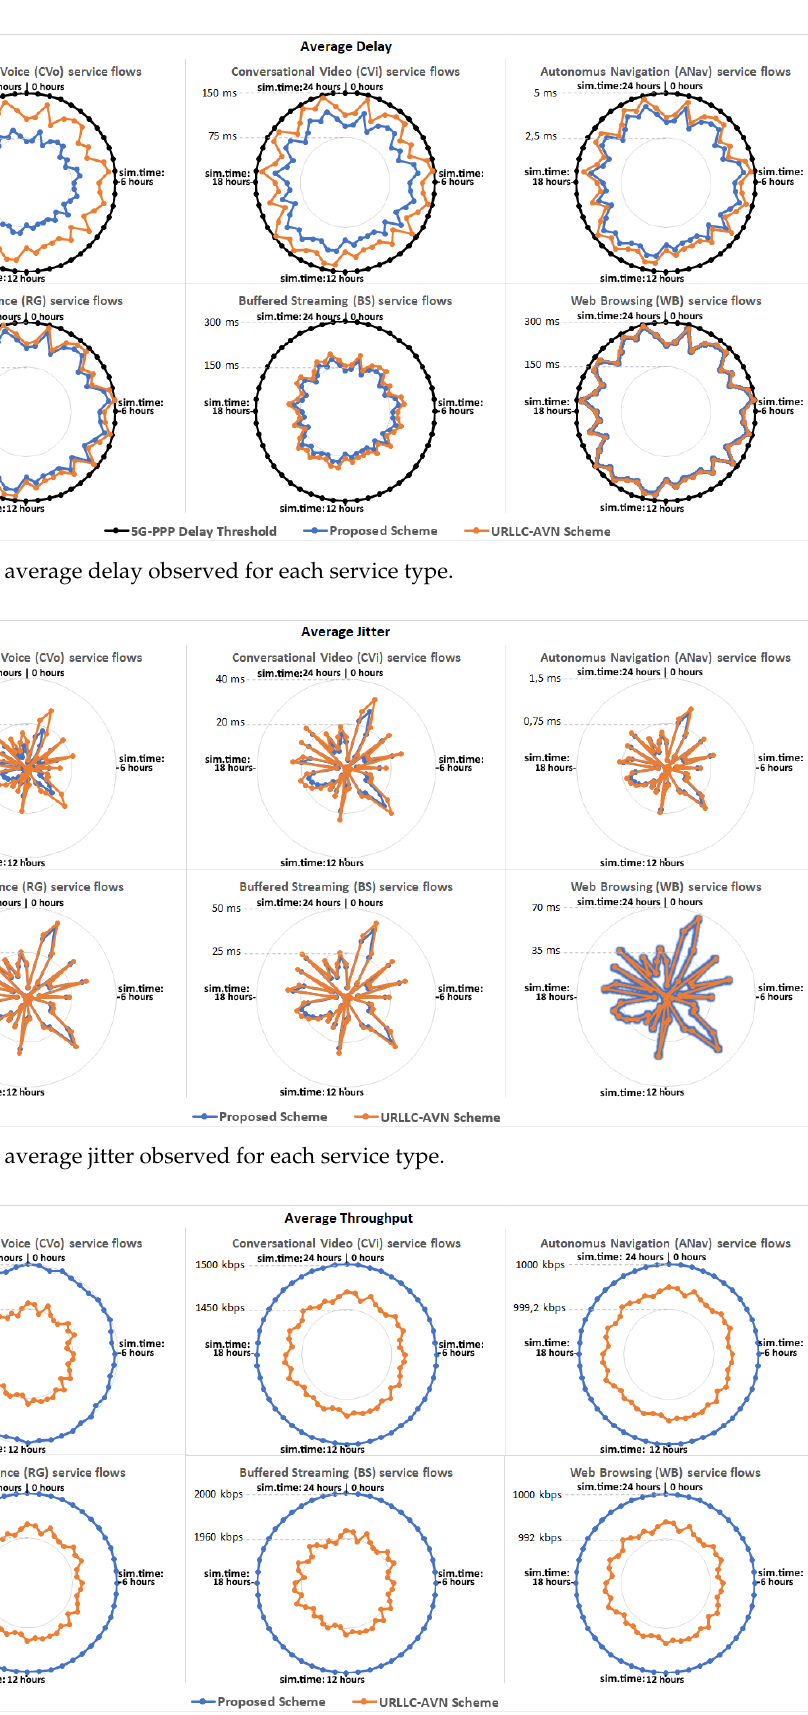
Figure 8. The average throughput observed for each service